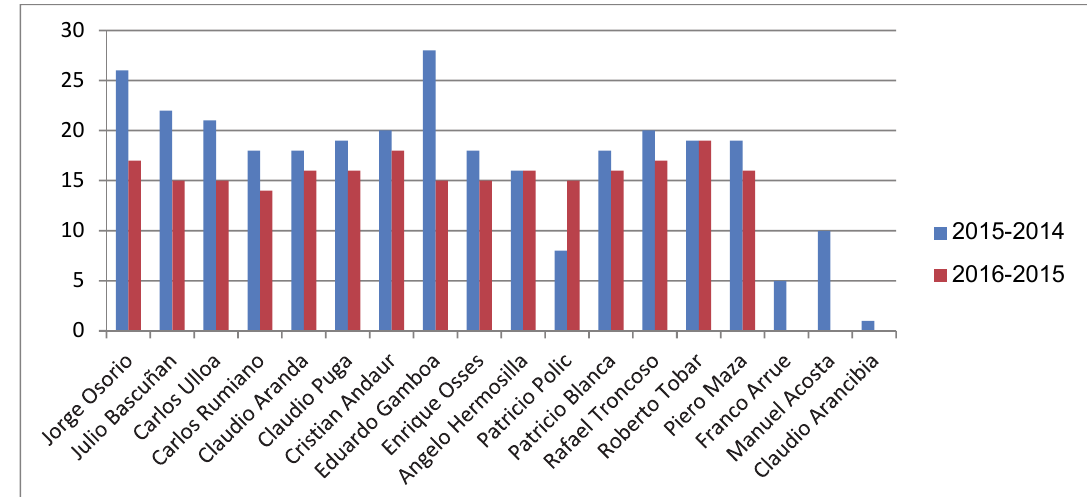
Fig. 1. Results for the number of matches directed by each referee. Source: The